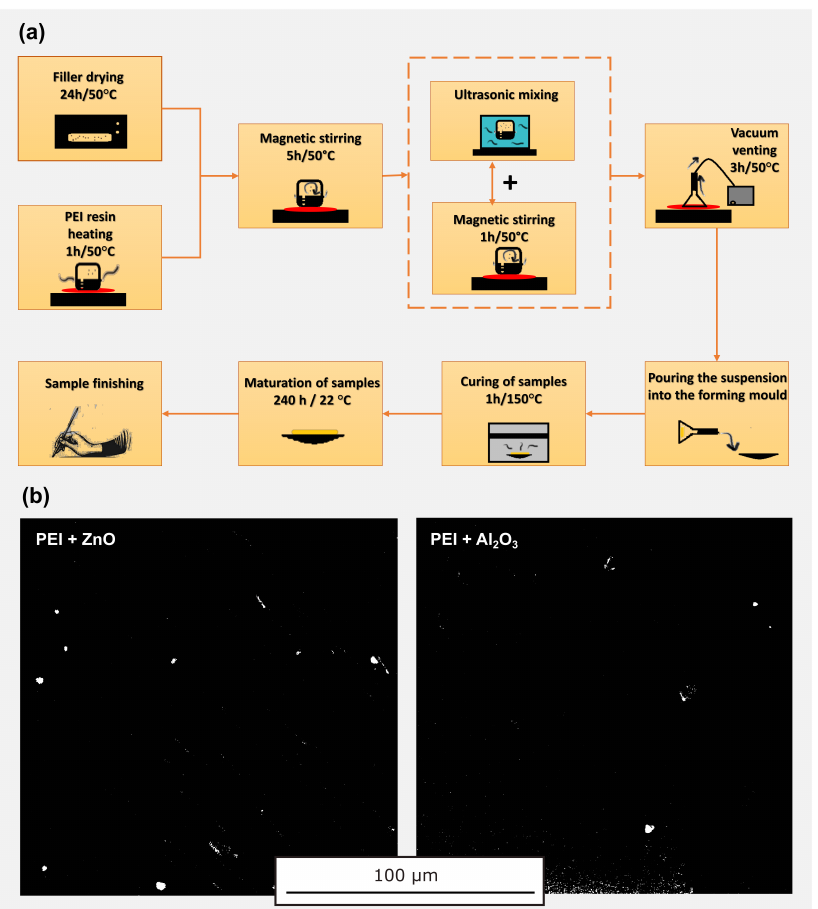
Figure 1. Preparation of PEI nanocomposites: ( a ) production diagram; ( b ) verification of particles dispersion by